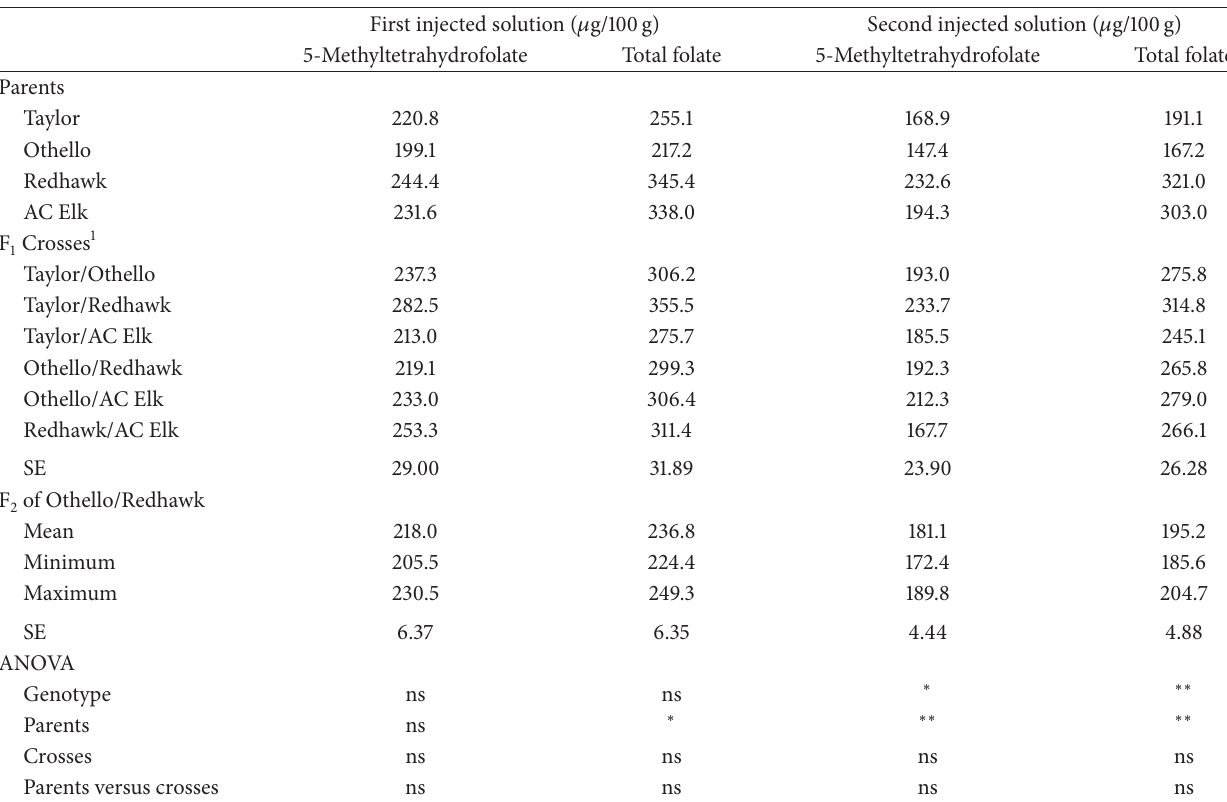
Table 1: Least squared means, standard errors, and the summary of ANOVA for four measurements of total and 5-methyl tetrahydrofolate , and the F of Othello/Redhawk measured in two injected solutions at one-hour contents of four dry bean varieties, their six F 1 2